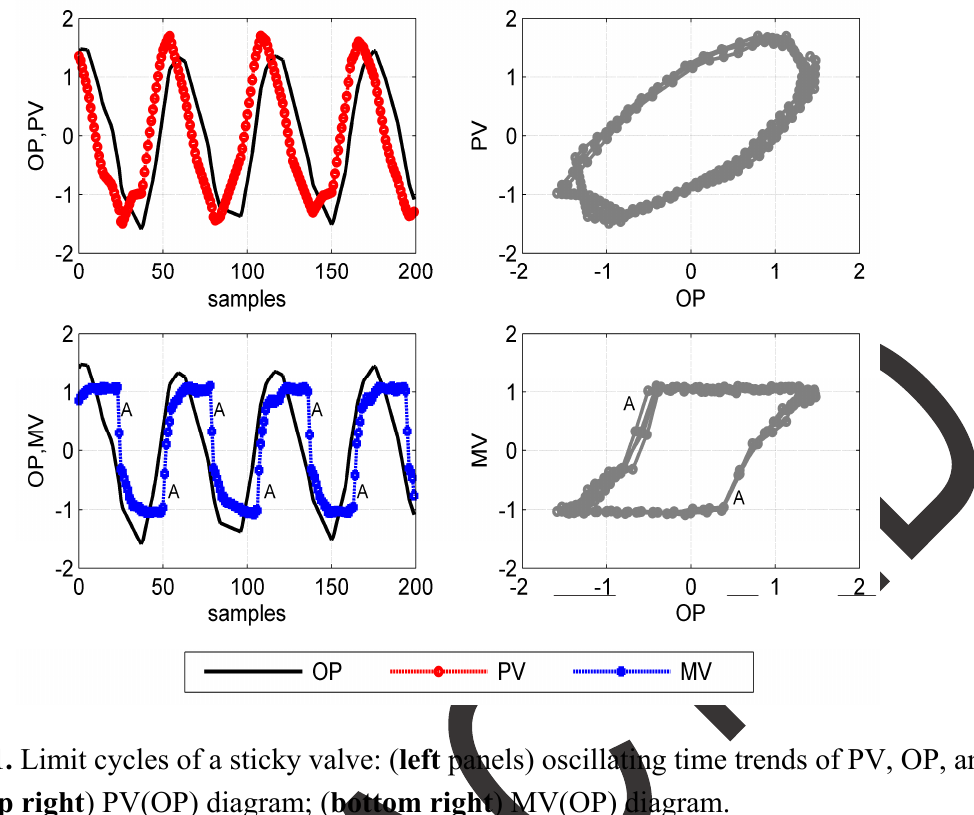
Figure 1. Limit cycles of a sticky valve: ( left panels) oscillating time trends of PV, OP, and MV; ( top right ) PV(OP) diagram; ( bottom right ) MV(OP)